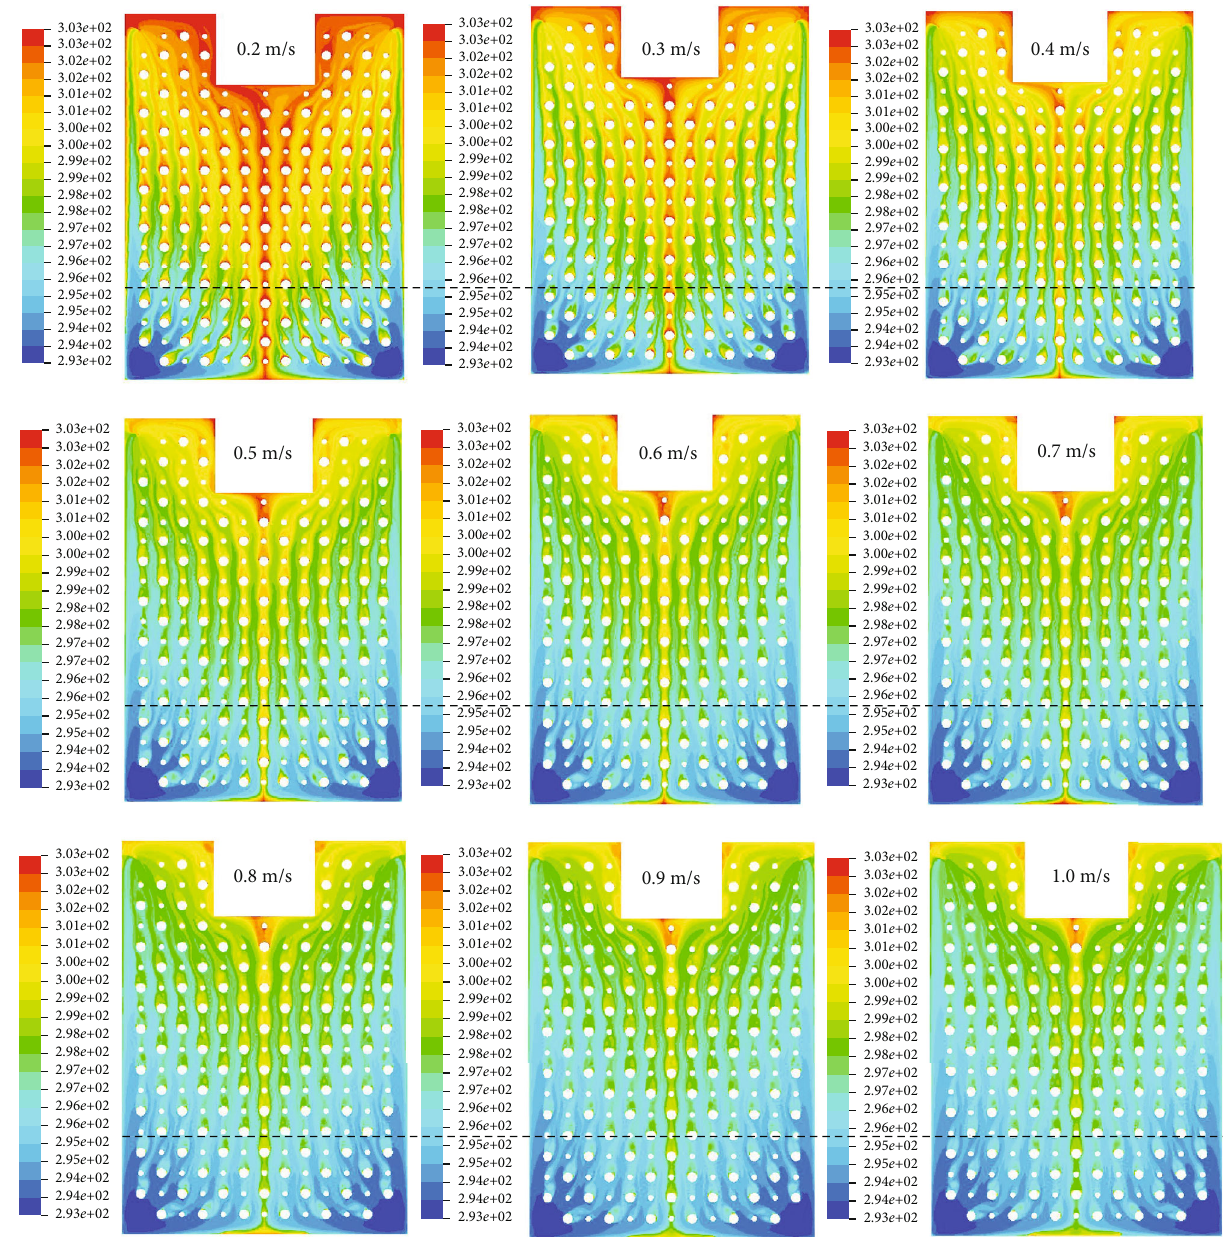
Figure 5: Temperature distribution (in K) at di ff erent inlet fl ow